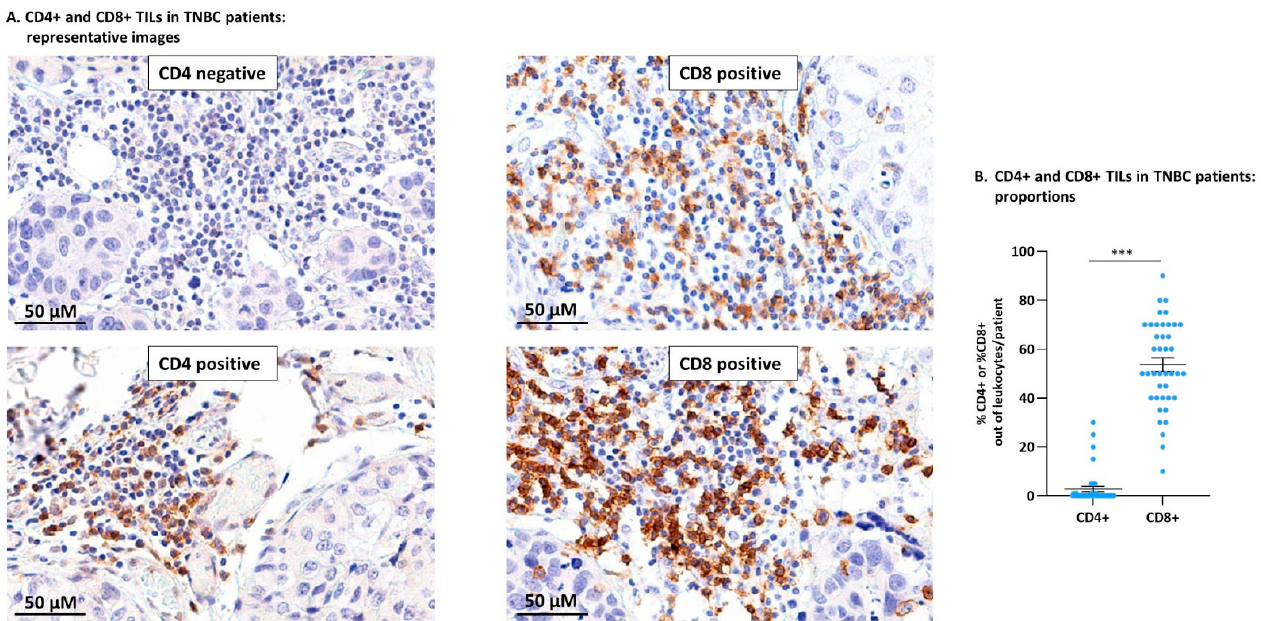
Figure 1. In TNBC patient tumors, CD8+ TILs dominated the T cell landscape over CD4+ TILs. Biopsy sections of TNBC patients were analyzed for the presence of CD4+ and CD8+ TILs using immunohistochemistry. ( A ) Images of representative sections stained for CD4 (two different patients: one negative for CD4+ TILs, the second positive for CD4+ TILs) and CD8 (two different patients: both positive for CD8+ TILs). Bar: 50 µm. ( B ) Semi-quantitative analysis of %CD4+ TILs and %CD8+ TILs out of the leukocyte infiltrate in TNBC patients (n = 41). Data are presented as average ± SE of percentages of the specific subset in all patients. The value of each patient is represented as a dot. *** p < 0.001 (two-tailed unpaired Student’s t -test).